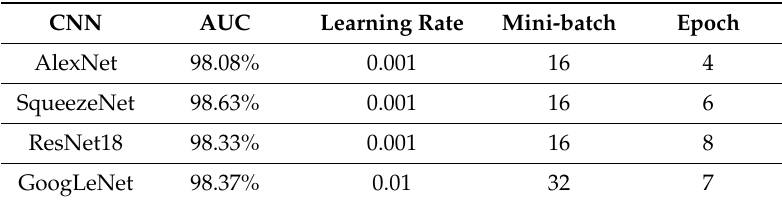
Table 6. Best Hyperparameter.